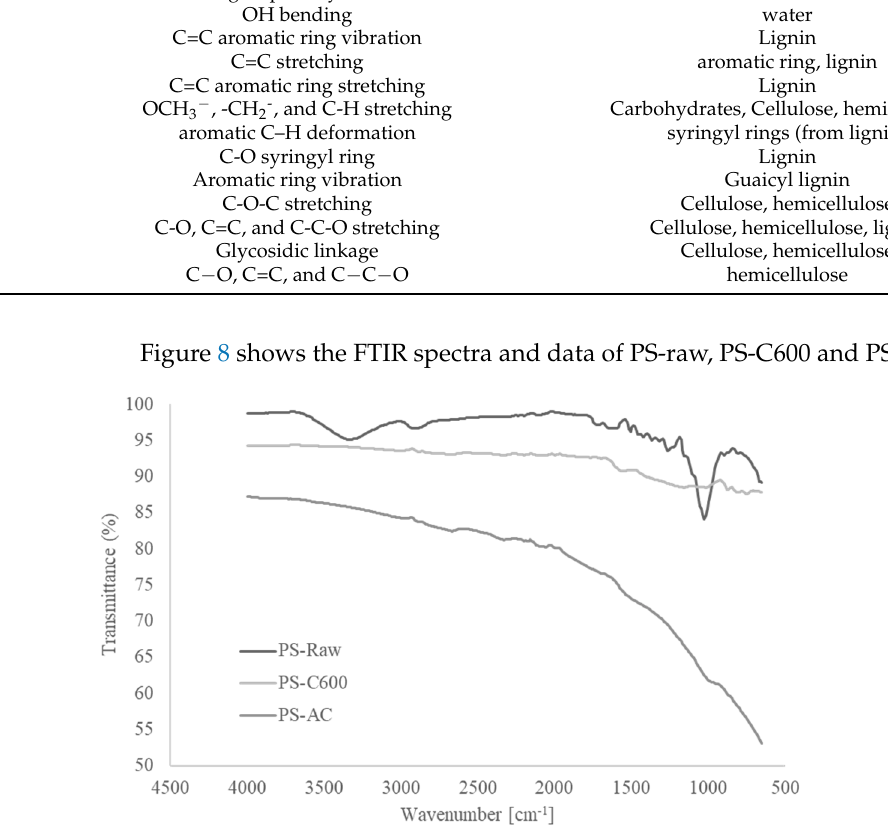
Figure 8. FTIR analysis of biomass and Figure 8 . FTIR analysis of biomass and biochar.